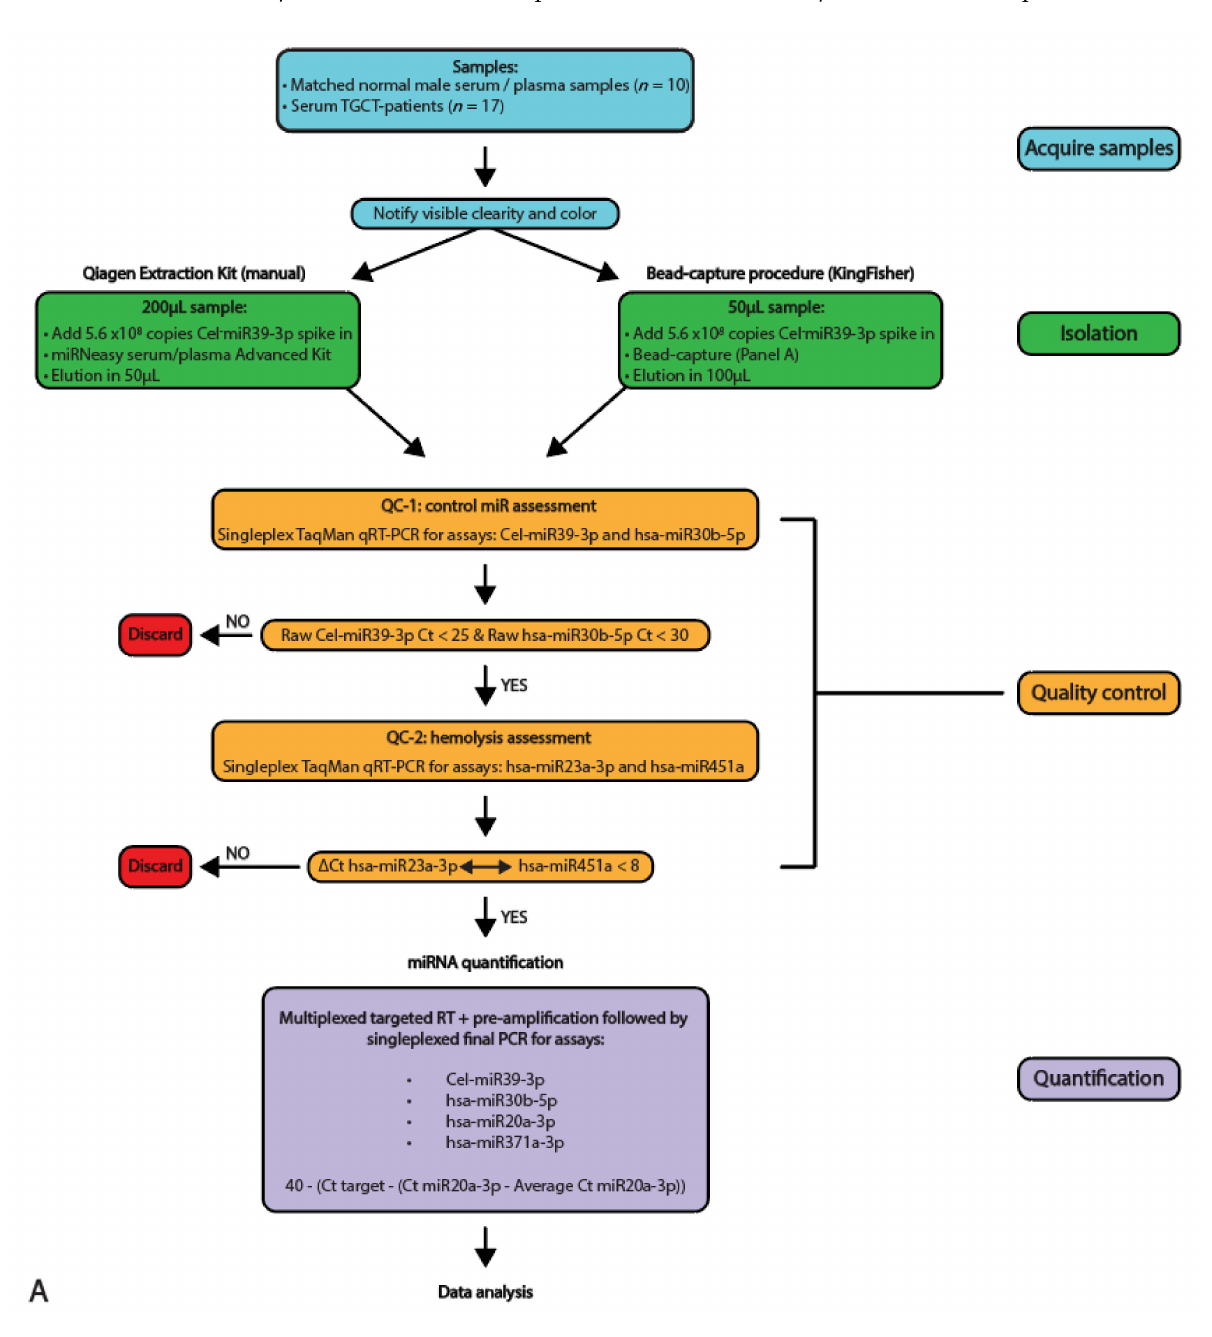
and Table S5). We present no differences between the Qiagen kit or